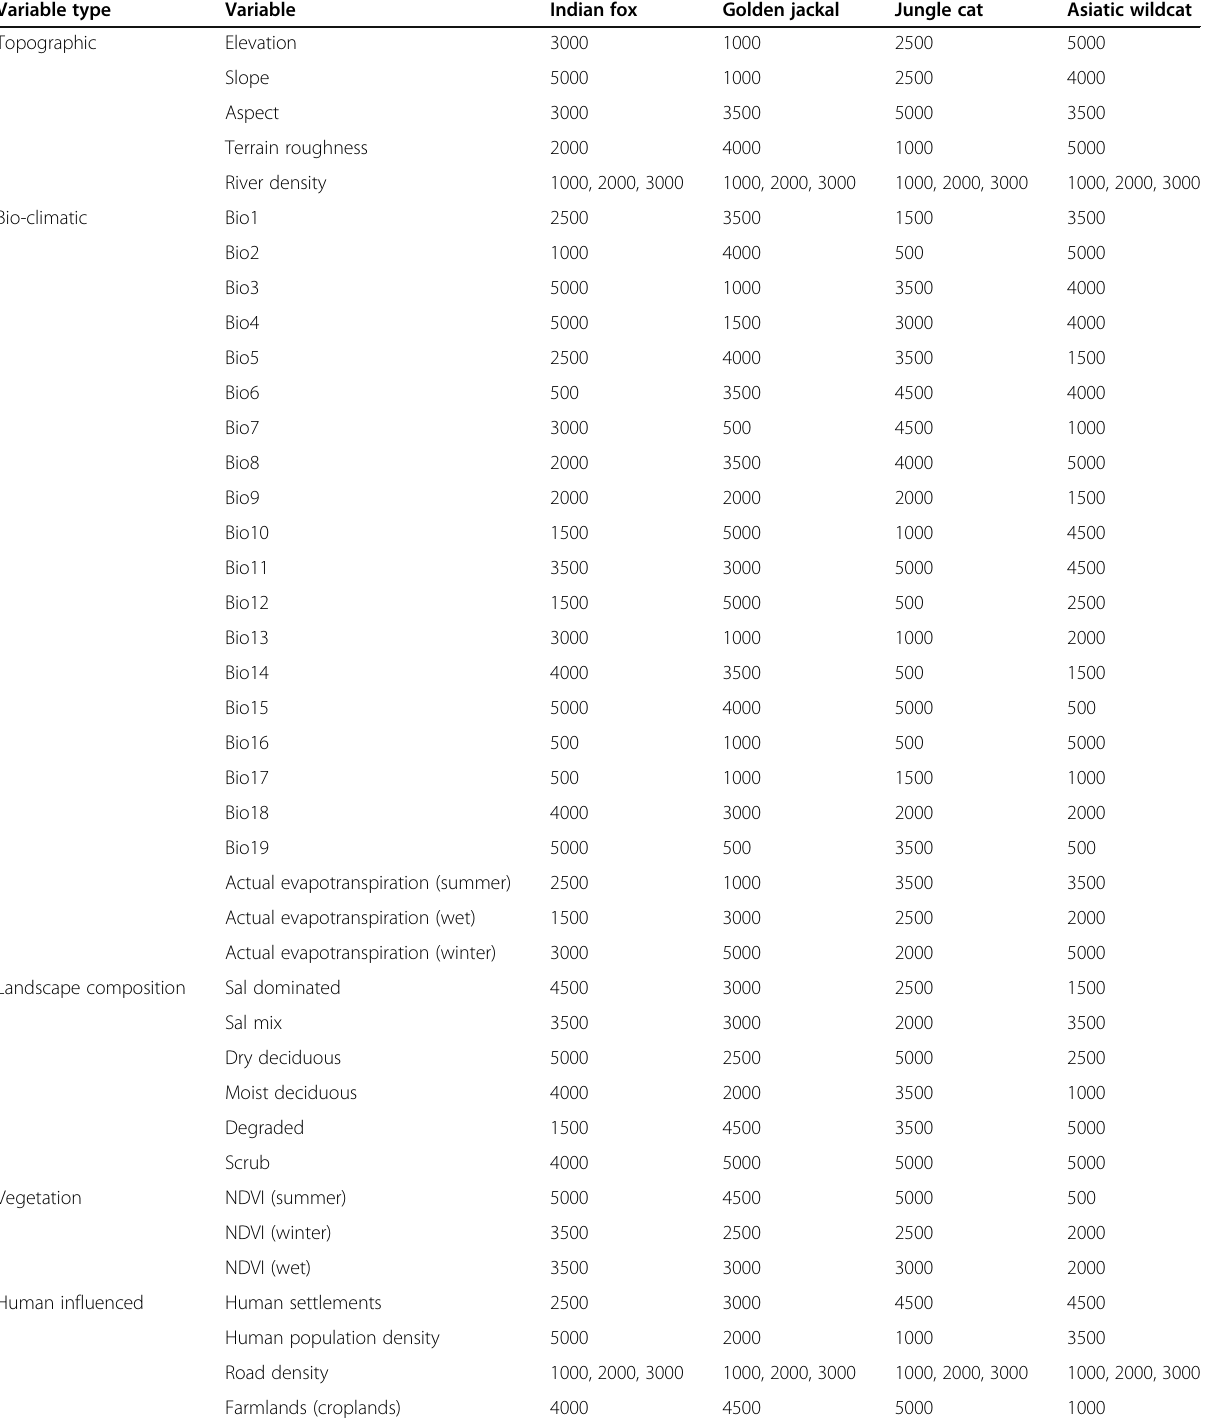
Table 1 The set of 40 predictor variables used in multi-scale habitat modeling of Indian fox, golden jackal, jungle cat, and Asiatic wildcat at most influential spatial scale. All the variables were resampled at the spatial resolution of 90 m. The LULC layer was obtained from Indian Institute of Remote Sensing for the year 2005 Variable